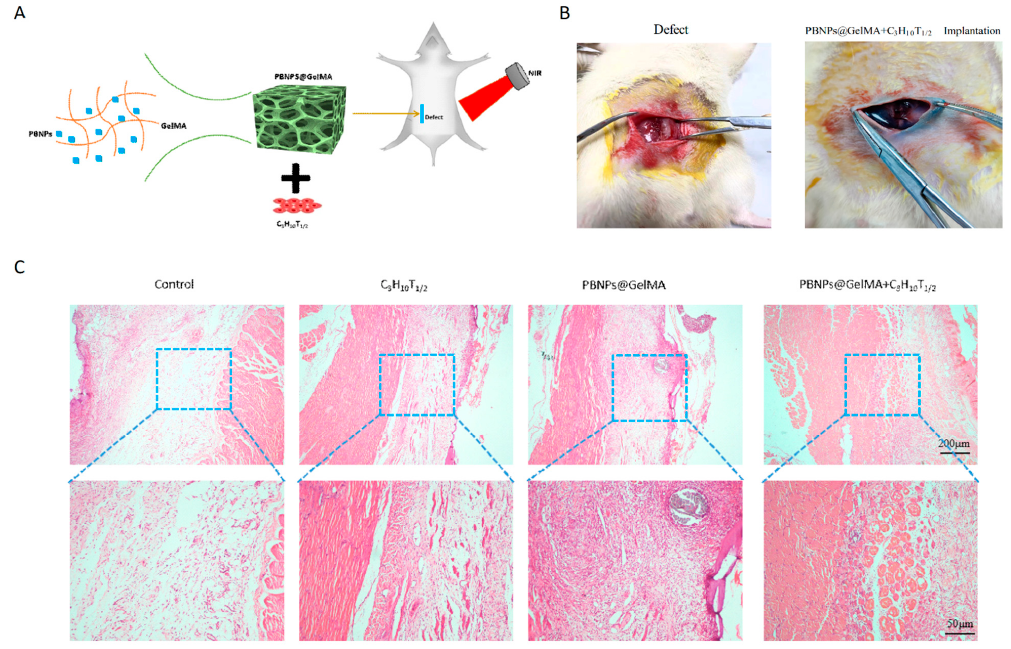
Figure 4. Good histocompatibility of PBNP@GelMA. ( A ) Schematic diagram of surgical repair process mediated by the implantation of heat-shock-pretreated MSCs. ( B ) General view of the injured site with or without the scaffold–cell complexes. ( C ) HE staining of abdominal wall muscle defect treated with control, MSCs, PBNP@GelMA, and MSCs + PBNP@GelMA 2 weeks after surgery.